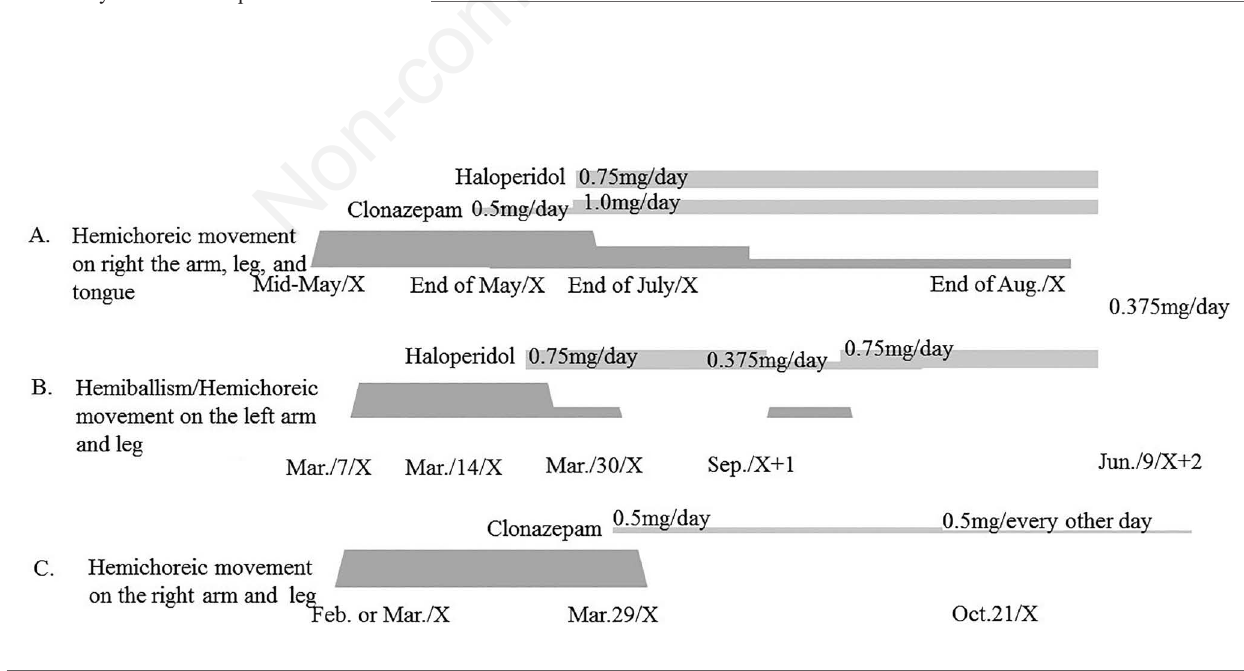
Figure 2. Clinical courses of the three hemichorea-hemiballism (HCHB) cases (A; case 1, B; case 2, C; case 3) X means the year when HCHB